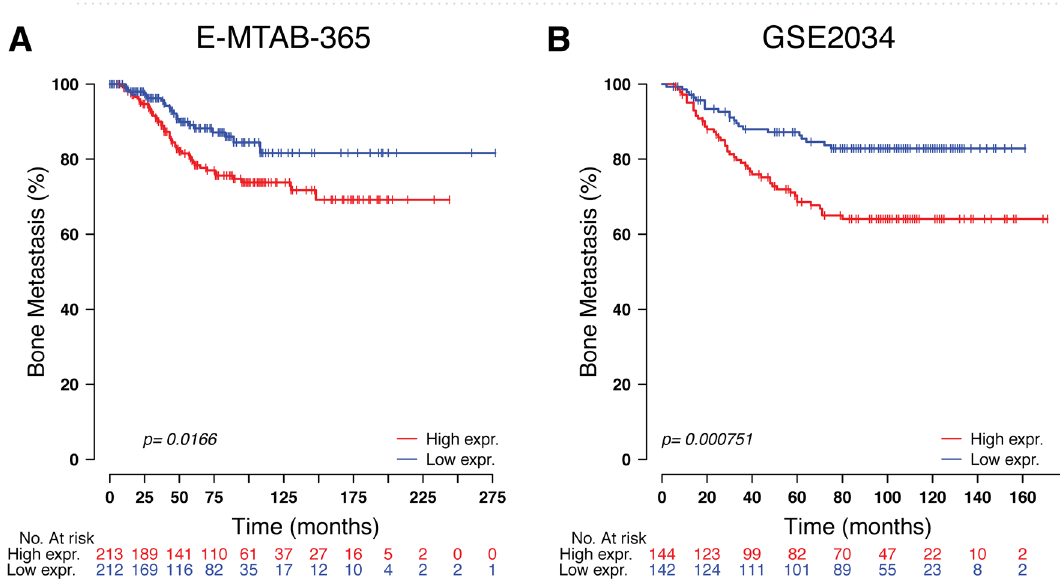
Figure 4. Kaplan ‒ Meier plots for bone metastasis of TOR1B expression. Kaplan ‒ Meier curve based on the expression of TOR1B in breast cancer patients from the E-MTAB-356 ( A ) and GSE2034 ( B ) datasets. The p value was calculated by log-rank